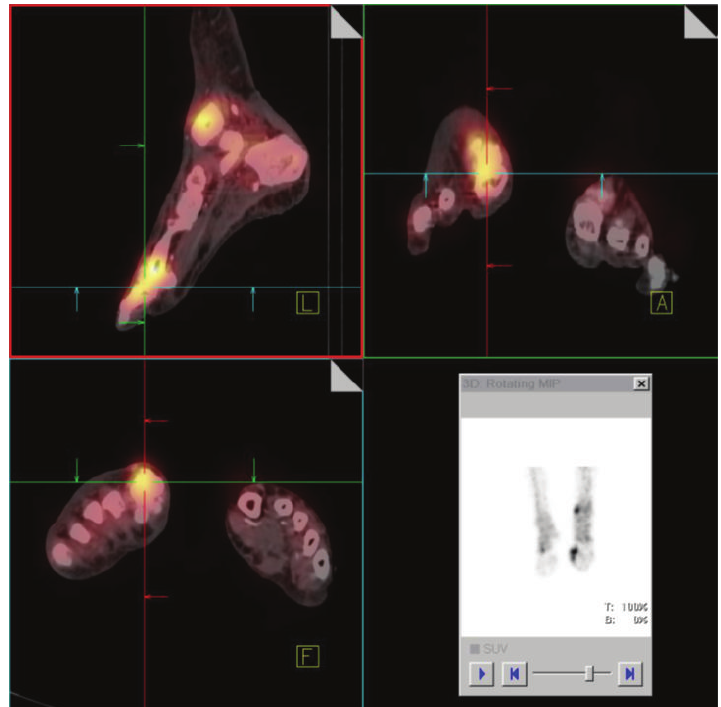
Figure 4: Merged SPECT/CT imaging of the lower extremities localizes the increased tracer uptake exactly at the distal tibia and MTP I.